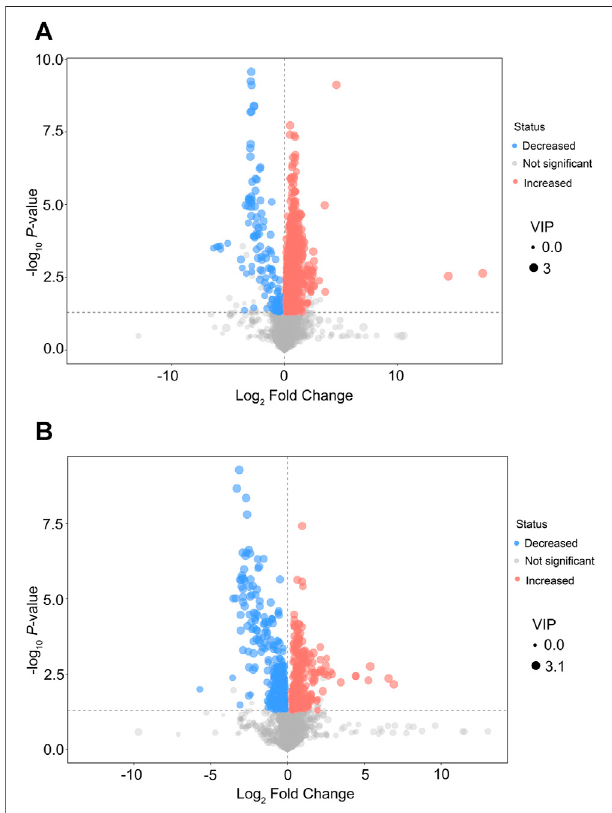
FIGURE 3 | Volcano plots of differential features of metabolites between the EA group and the non-EA group. 1,108 features in the positive mode (A) and 586 features in the negative mode (B) were selected using the criteria of VIP > 1 and p < 0.05. As shown in the volcano plots, the increased and decreased features were marked as red and blue,